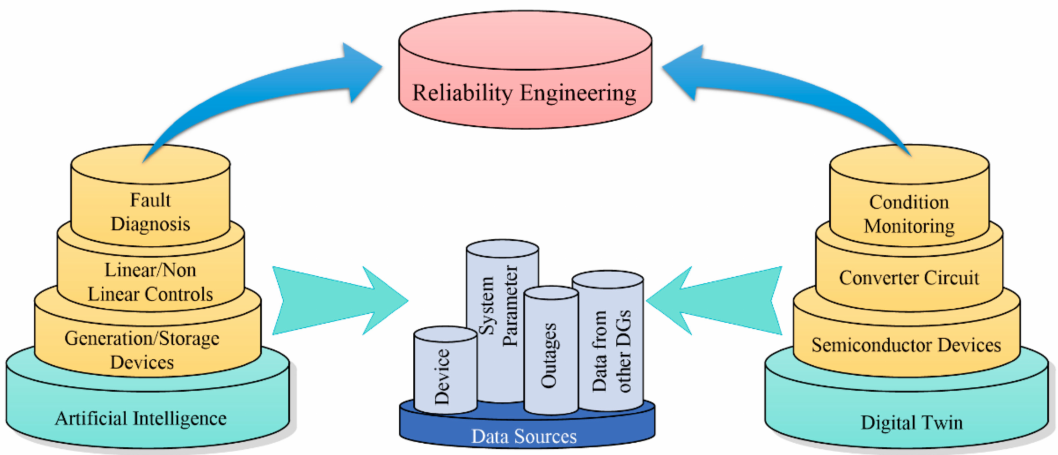
Figure 14. Application of digital twin for different functions with PV system.